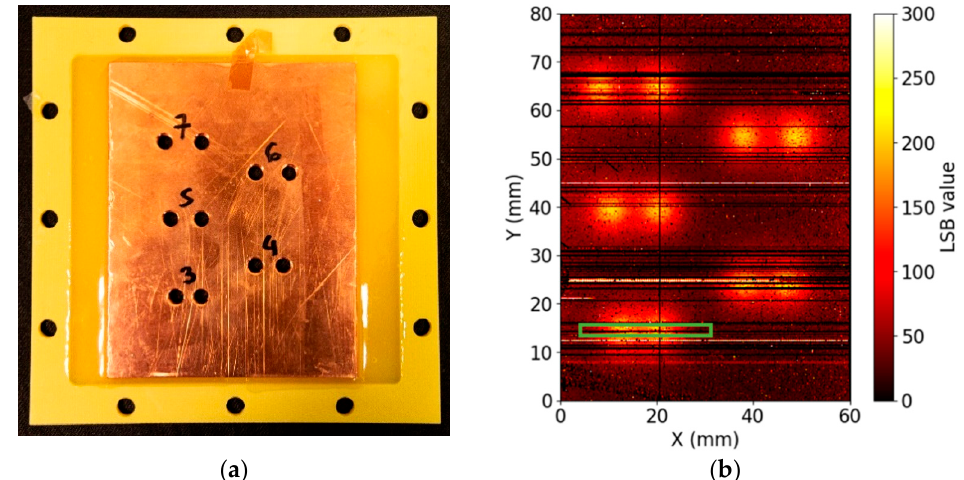
Figure 7. ( a ) The 3 mm-thick copper plate used for the evaluation of the spatial resolution using the LSF method. The numbers written on the plate represent the space between the holes in millimeters. ( b ) Heat map of the copper mask for 40 kV X-rays. A ROI (green rectangle) was set on the holes separated by 3 mm. The spatial resolution was estimated by fitting the profile in the ROI by a Gaussian function.